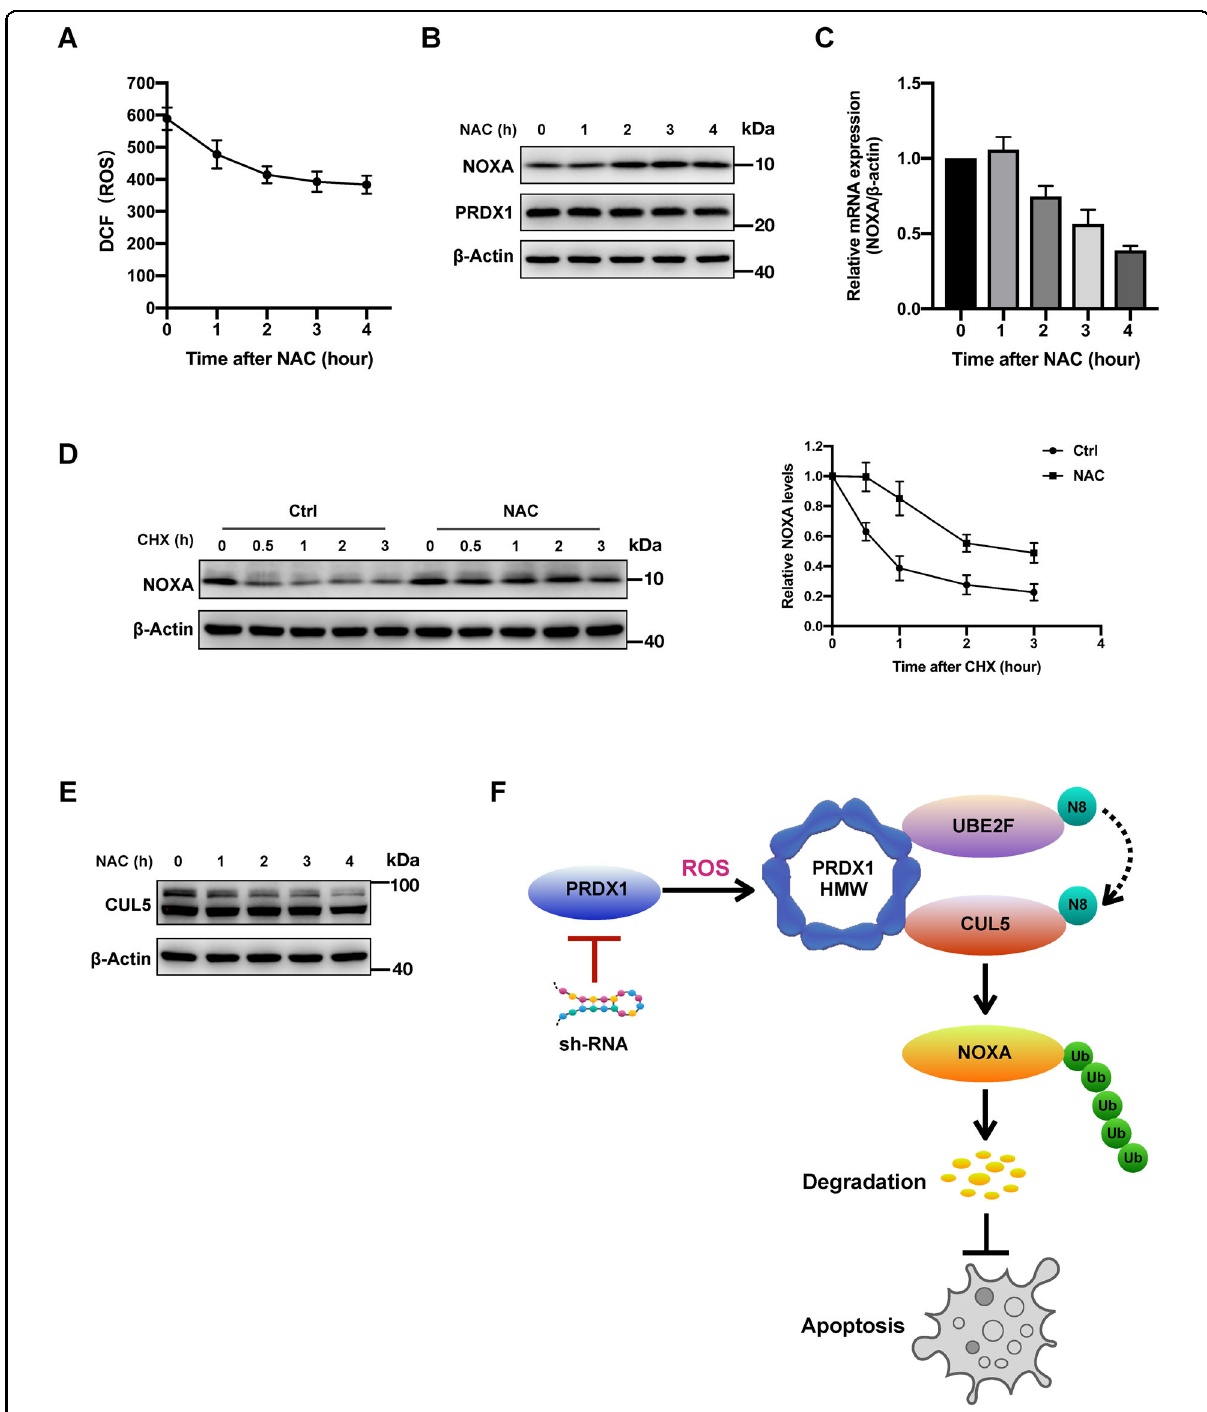
Fig. 6 (See legend on next